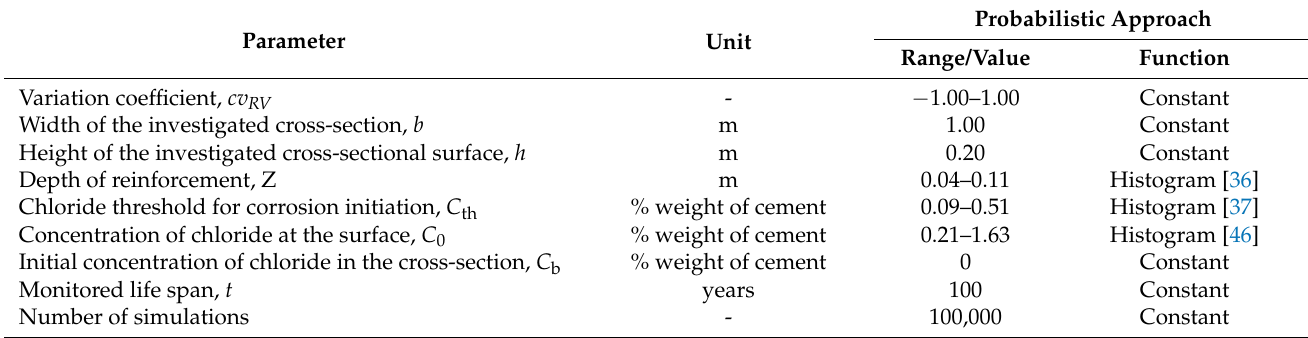
Table 3. Input variable parameter data for the